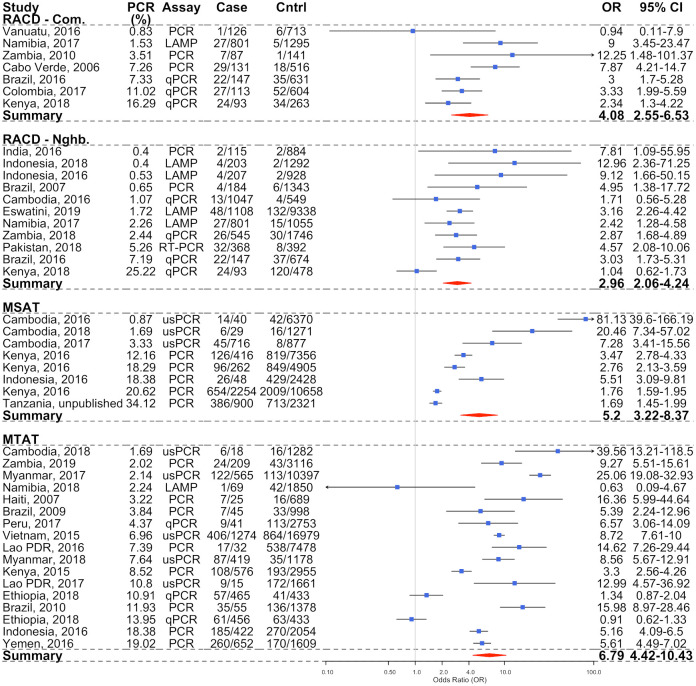
Forest plot showing the OR of PCR-detectable infections within case compared to control households (blue circles, and OR column), stratified according to the detection strategy.RACD according to community and neighbour control populations, MSAT, and MTAT with the 95% CIs are shown in the black lines for each OR and in the 95% CI column. The pooled OR statistics for each strategy, as calculated according to a random effects model, with study site as the random effect are shown as red diamonds, with the width representing the 95% CI. Studies are listed in ascending order of malaria PCR prevalence in the community. LAMP, loop mediated isothermal amplification; MSAT, Mass Screen and Treat; MTAT, Mass Test and Treat; OR, odds ratio; PCR, polymerase chain reaction; qPCR, quantitative PCR; RACD, Reactive Case Detection; usPCR, ultra-sensitive PCR.